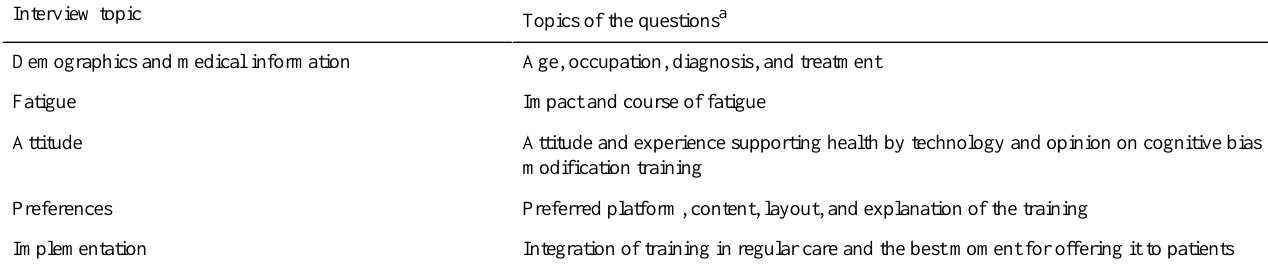
Table 1. Overview of the interview topics. trainingAttitude